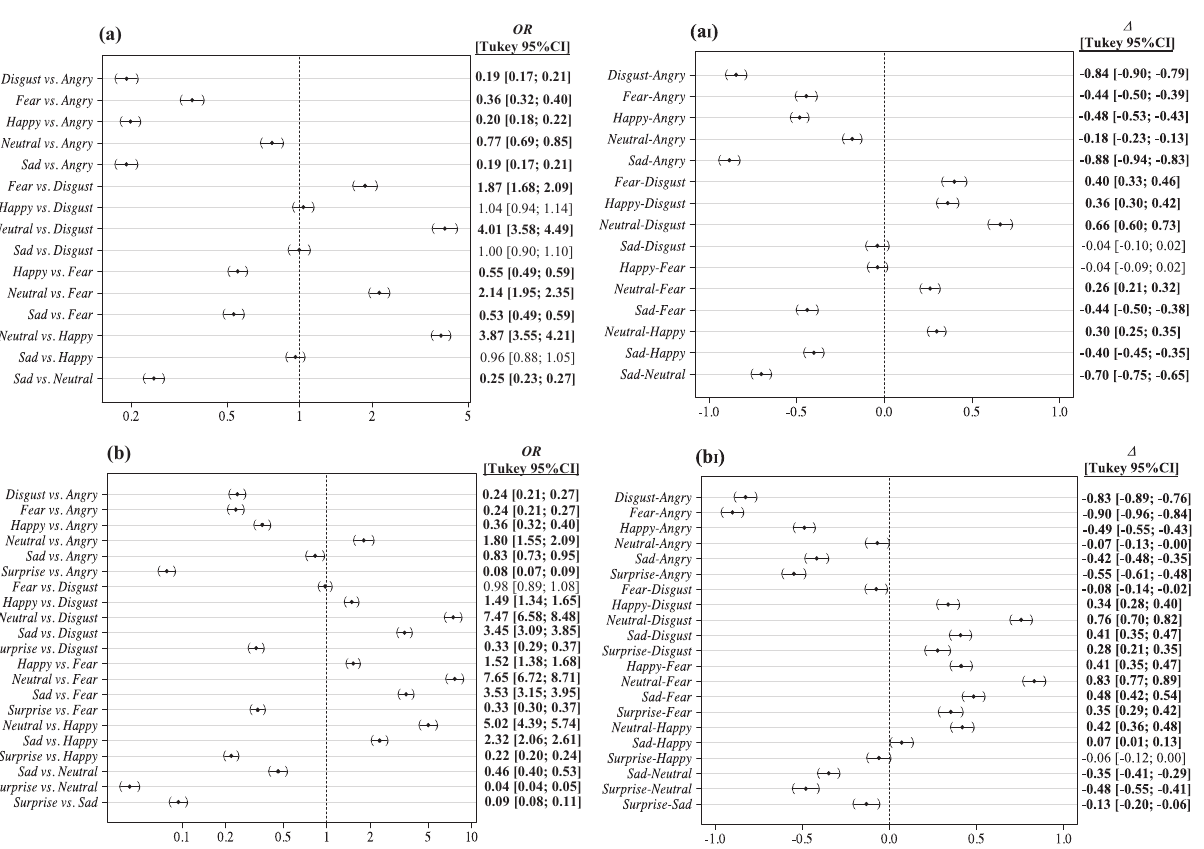
Fig. 3 Comparisons between emotion categories in Group Words (GW) and Group Sentences (GS). The odds ratio estimates (OR) for the comparisons between emotion categories are illustrated in panel a for GW and panel b for GS, while the linear contrasts ( Δ ) for con fi dence ratings are illustrated in panel a I for GW and b I for GS. Odds ratio of emotion 1 (e.g., disgust ) vs. emotion 2 (e.g., angry ) less than 1 indicate that the recognition probability of emotion 2 (e.g., angry ) is higher than of emotion 1 (e.g., disgust ), whereas values greater than 1 vice-versa. If the odds ratio of 1 is covered in the con fi dence interval, the difference in the recognition probabilities is not signi fi cant. Negative differences of con fi dence ratings of emotion 1 (e.g., disgust ) vs. emotion 2 (e.g., angry ) indicate that the con fi dence ratings of emotion 2 (e.g., angry ) is higher than of emotion 1 (e.g., disgust ), whereas positive differences vice-versa. If the difference of zero is covered in the 95%CI, the difference in the con fi dence ratings is not signi fi cant. The signi fi cant combinations are highlighted in